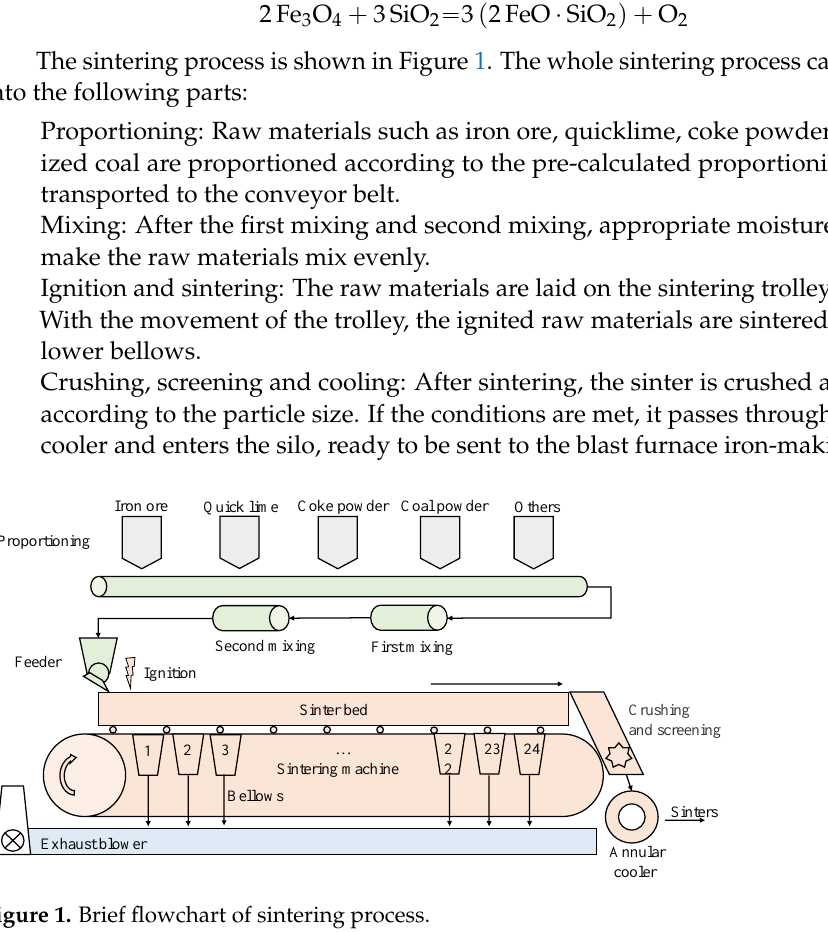
Figure 1. Brief flowchart of sintering